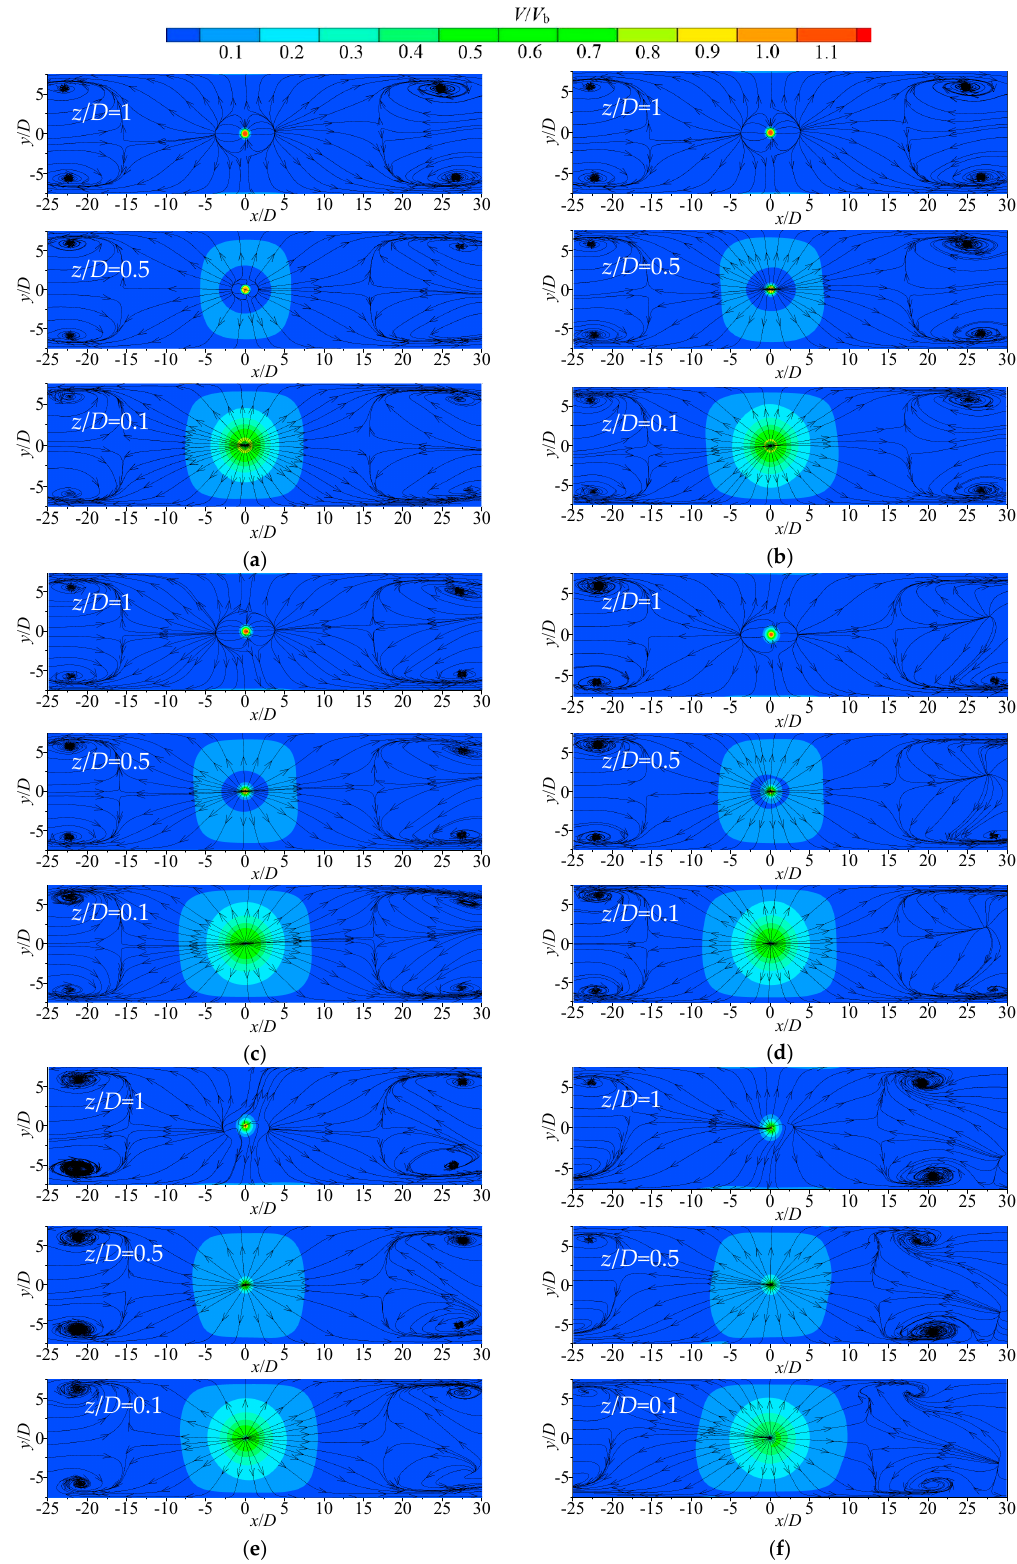
Figure 6. Normalized mean velocity V / V b contour and streamline of di ff erent cross sections on submerged impinging jet at various impinging heights: ( a ) H / D = 1; ( b ) H / D = 2; ( c ) H / D = 3; ( d ) H / D = 4; ( e ) H / D = 6; ( f ) H / D =